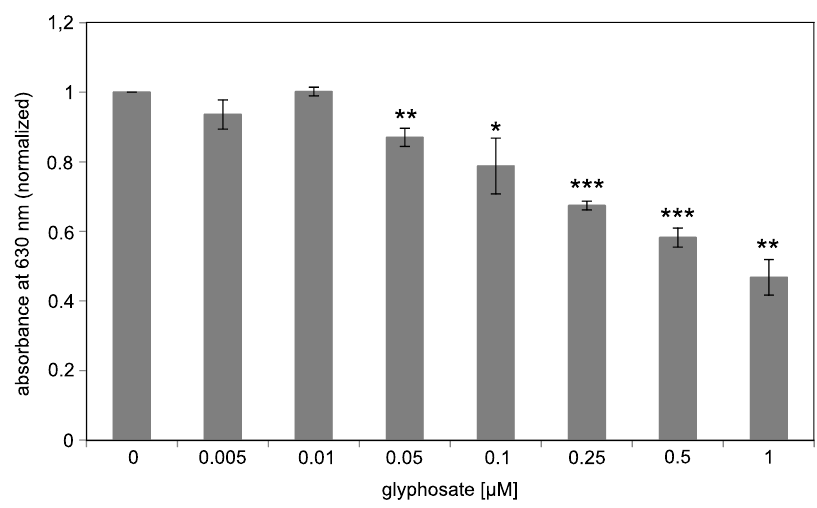
Figure5. InhibitionofimmobilizedCcg2_GS_EcEPSPSbyglyphosate. MeasurementofEcEPSPSactivity using the malachite green assay with a glass surface functionalized with 1 µ M Ccg2_GS_EcEPSPS:5 µ M Ccg2. Results were normalized to the sample without glyphosate (0 µ M). The detection limit is 50 nM glyphosate. *** p ≤ 0.001; ** p ≤ 0.01; * p ≤ 0.05. Absorbance at a wavelength of 630 nm was